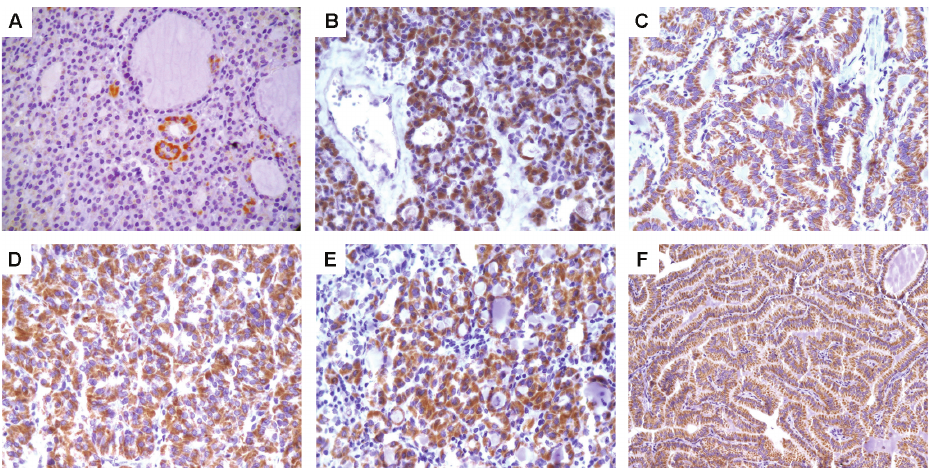
Figure 1 - Immunohistochemical expression of NDRG1 in thyroid lesions. A. Nodular goiter; original magnification, 400 6 . B. Follicular adenoma; original magnification, 400 6 . C. Classical papillary thyroid carcinoma; original magnification, 400 6 . D. Follicular variant of